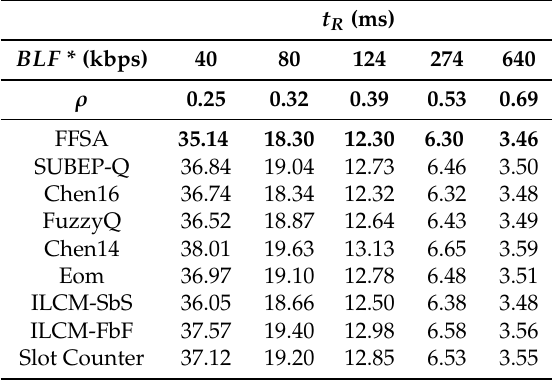
Table 5. Effect of BLF and ρ on the protocols’ performance in terms of t R in S2. Quantities in bold represent the best results among the protocols in the comparison. * Indicates the control variable.